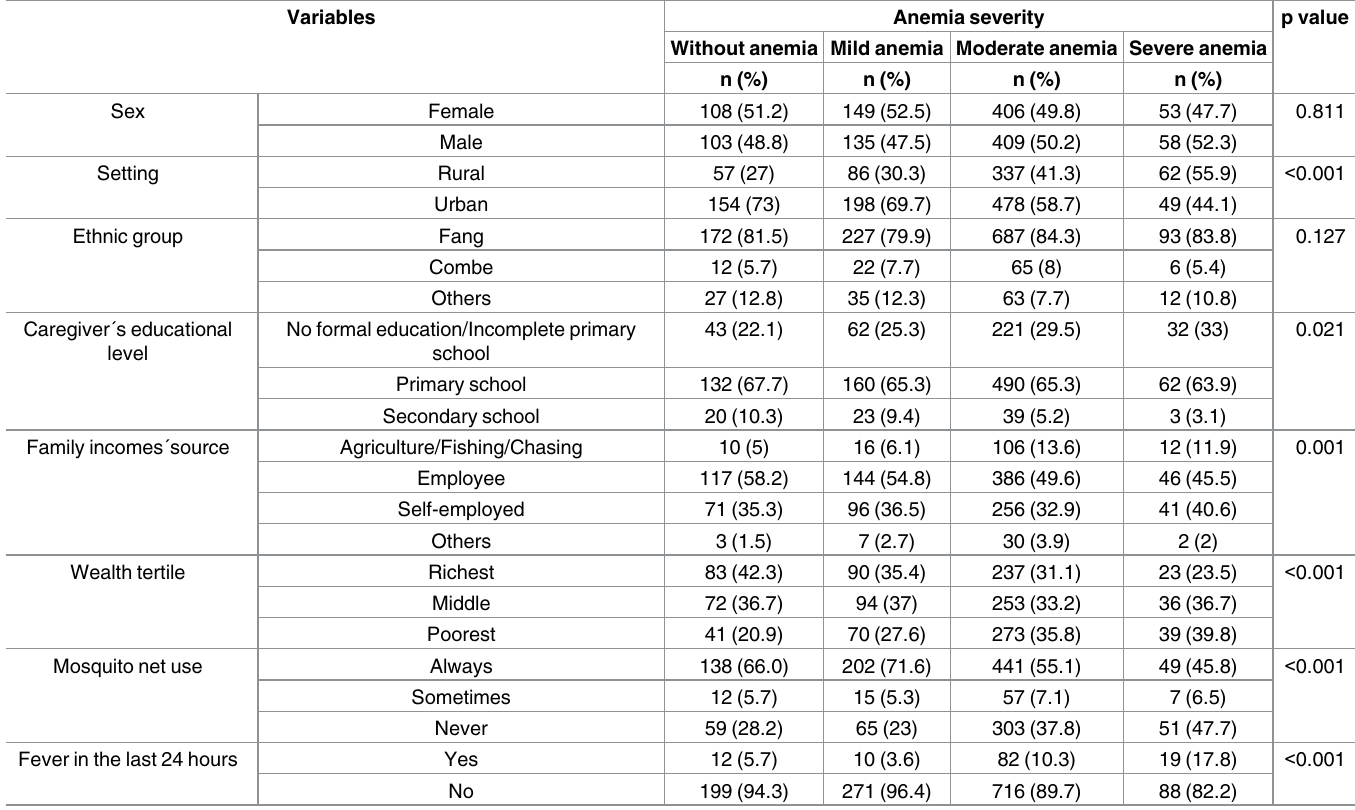
Table 2. Socio- demographic and clinical characteristics of the study population by anemia severity,Bata district, June-August 2013.